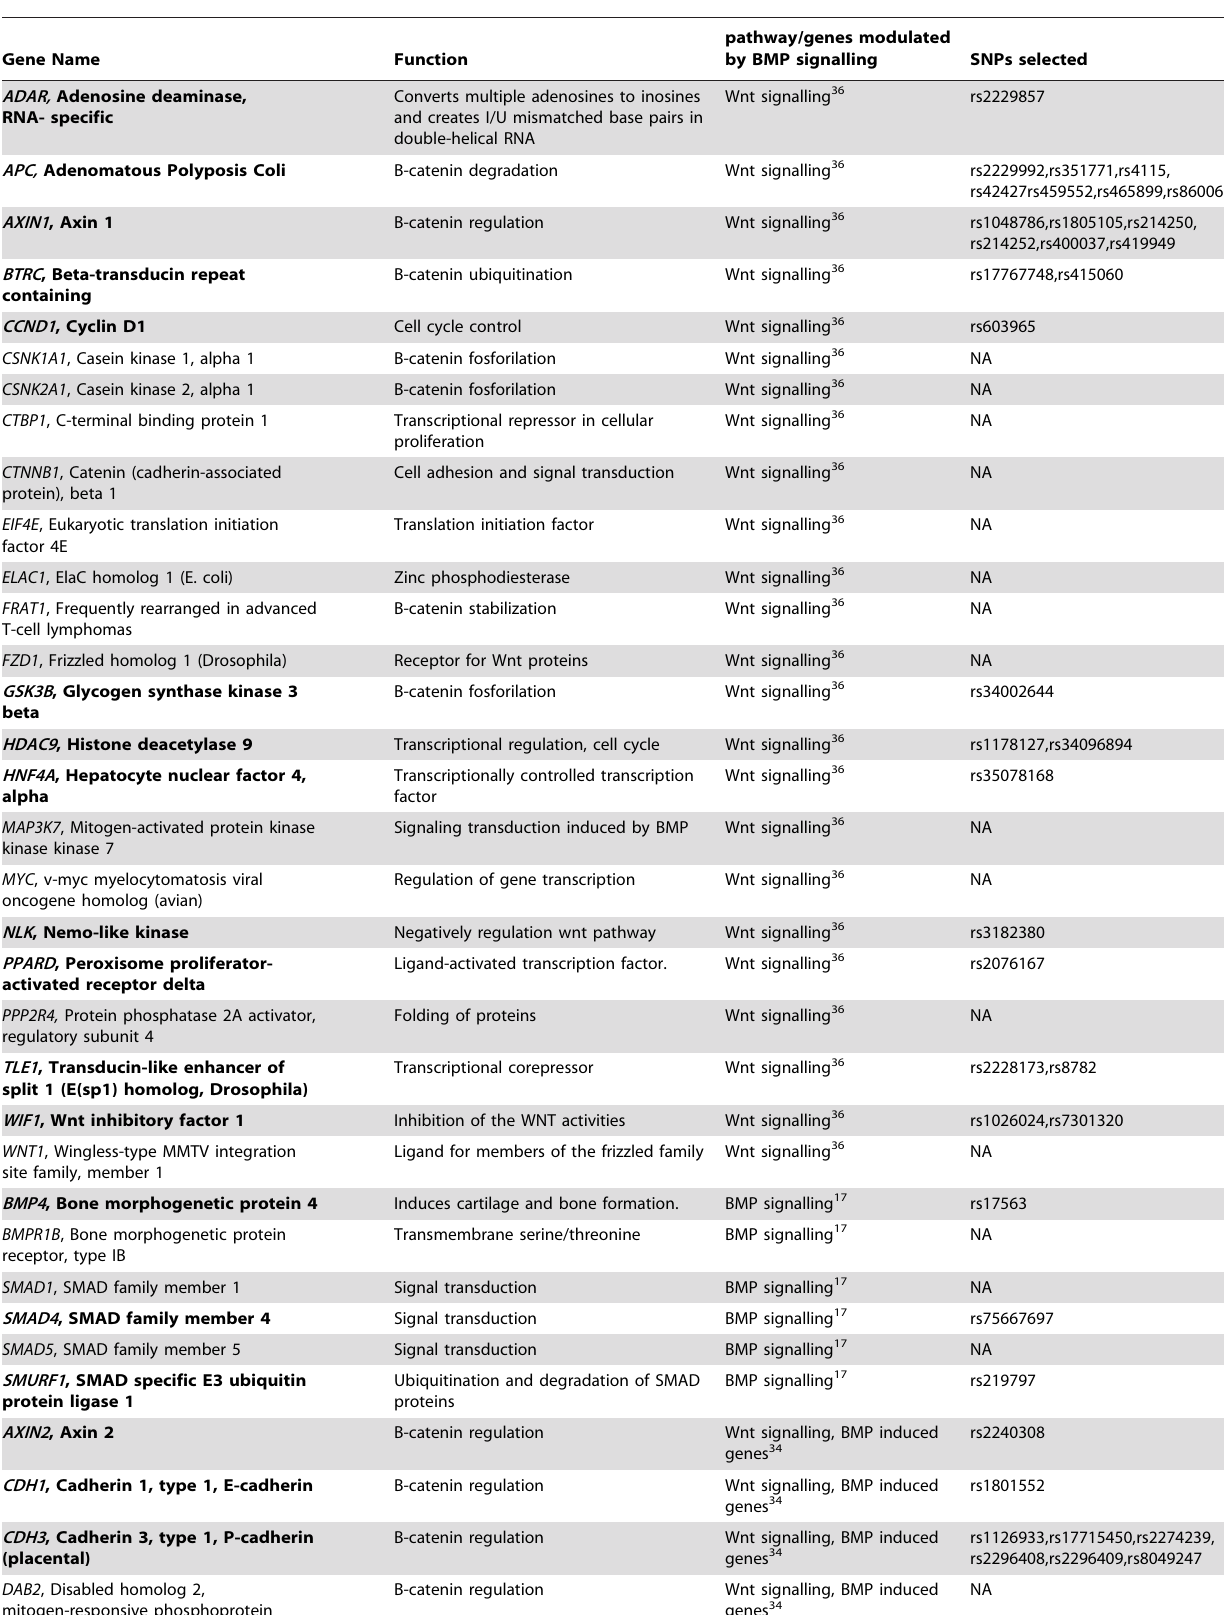
Table 3. Description of all genes selected from both pathways and SNPs screened within each of them.